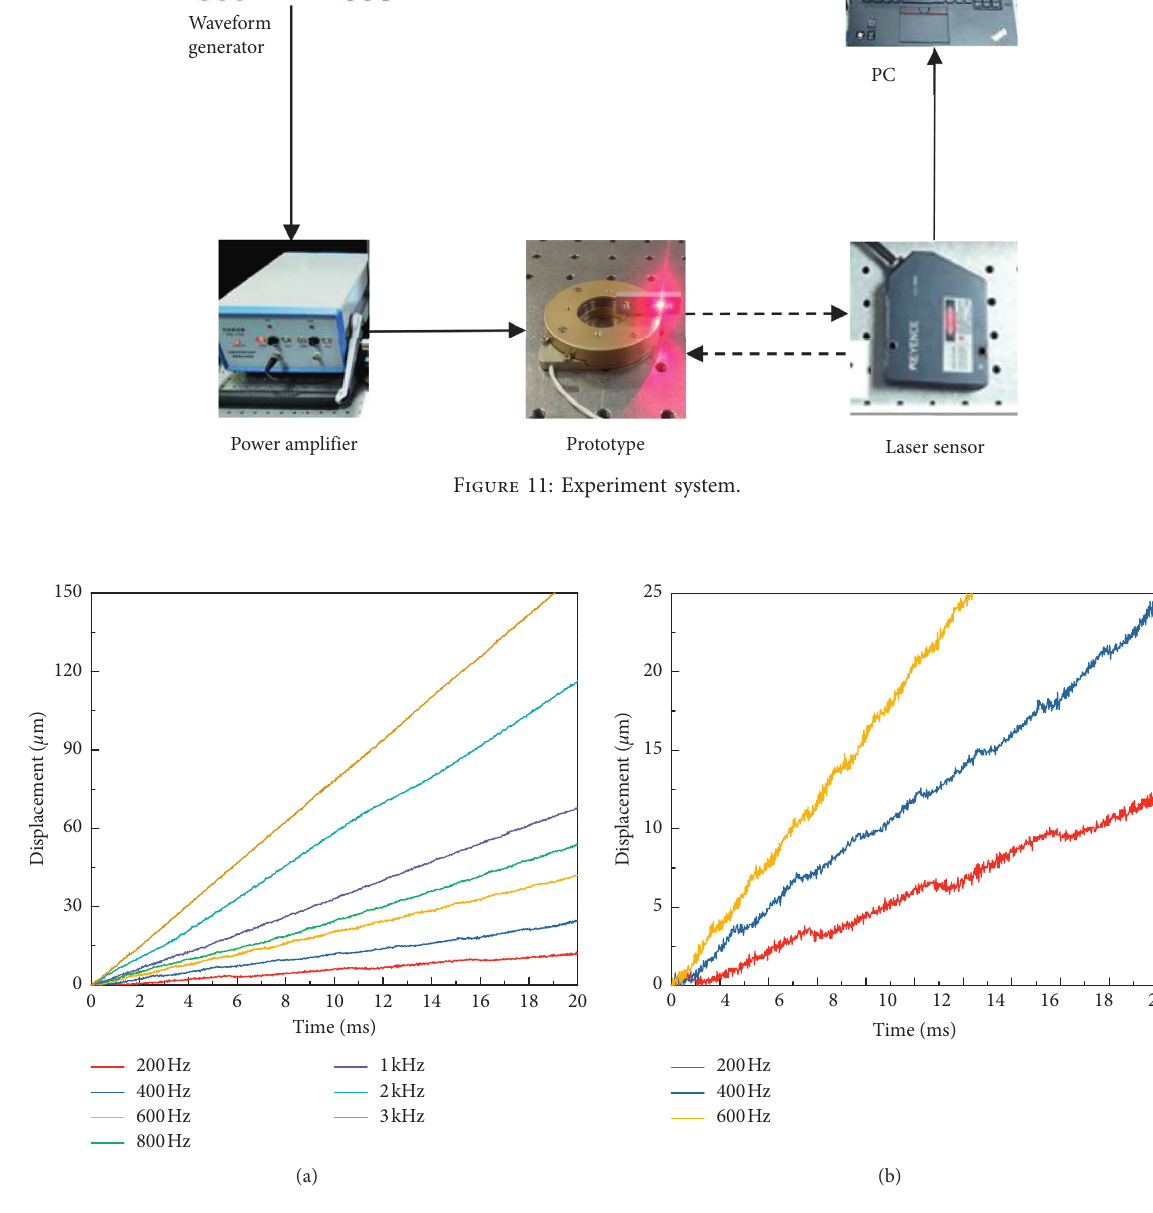
Figure 12: Output displacement under different frequencies of a 93V sawtooth